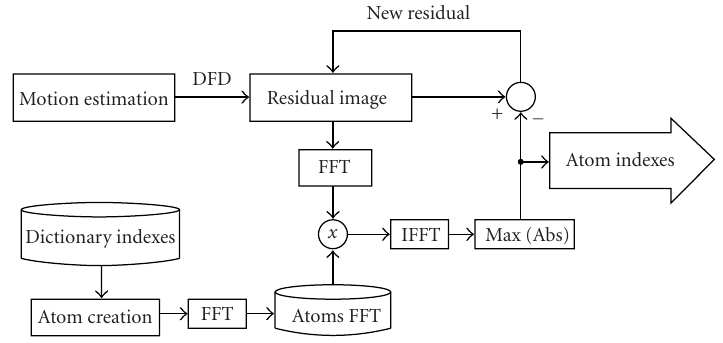
Figure 2: Scheme for the atom selection in the Fourier